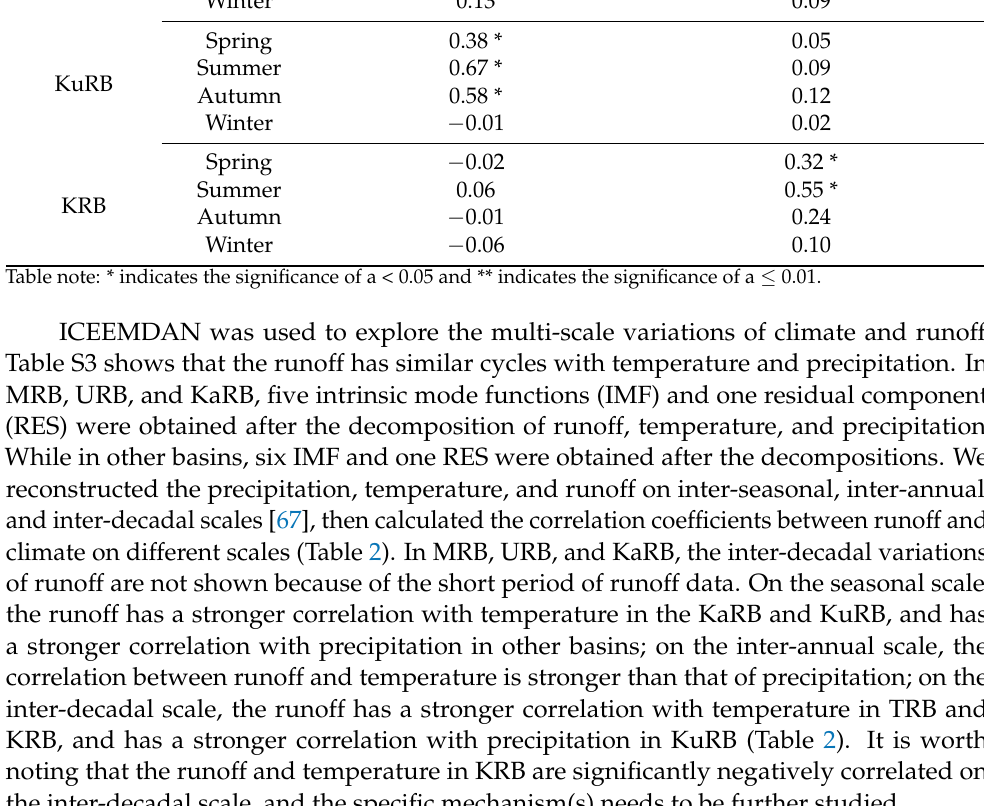
Table note: * indicates the significance of a < 0.05 and ** indicates the significance of a ≤ 0.01. ICEEMDAN was used to explore the multi-scale variations of climate and